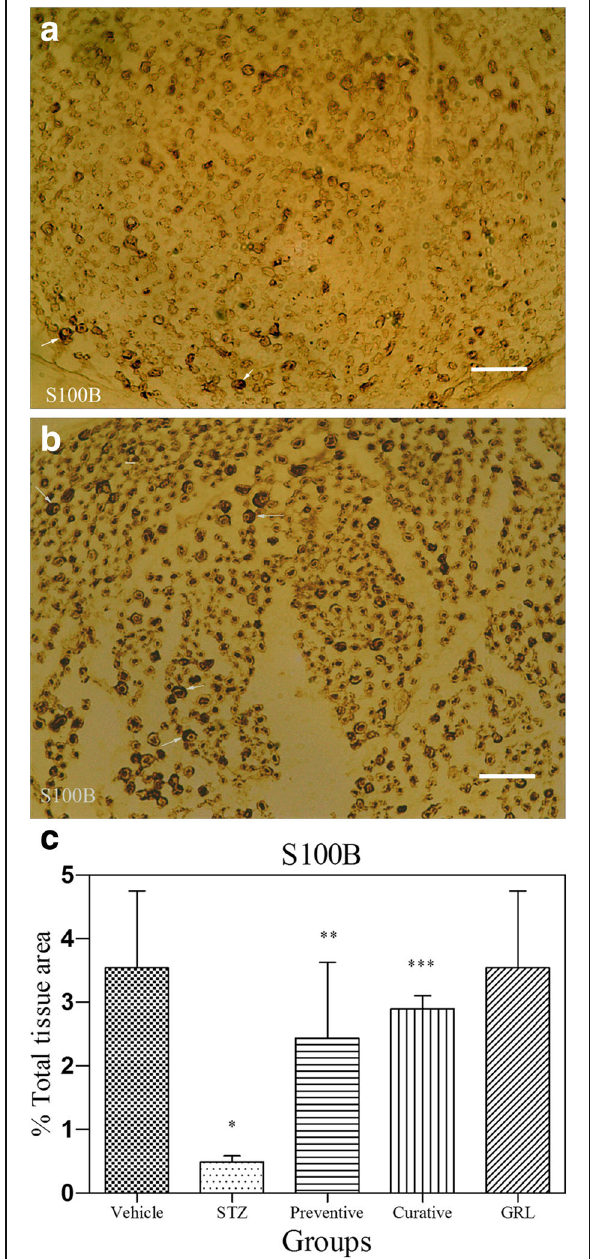
Fig. 7 Light Photomicrographs show immunohistochemical expression of S100B in STZ ( a ) and STZ plus GRL ( b ) groups (original magnification: ×400, bar: 250 μ m). The positive staining of S100B is presented by a brown color of cytoplasm (arrows). Densitometry analysis of immunohistochemical photomicrographs for S100B was assessed. Data are expressed as a percentage of total tissue area ( c ) of 7 rats/group. * P < 0.001 versus vehicle and GRL group; ** P < 0.05 versus STZ group; *** P < 0.01 versus STZ group by one-way ANOVA followed by Tukey ′ s post-hoc